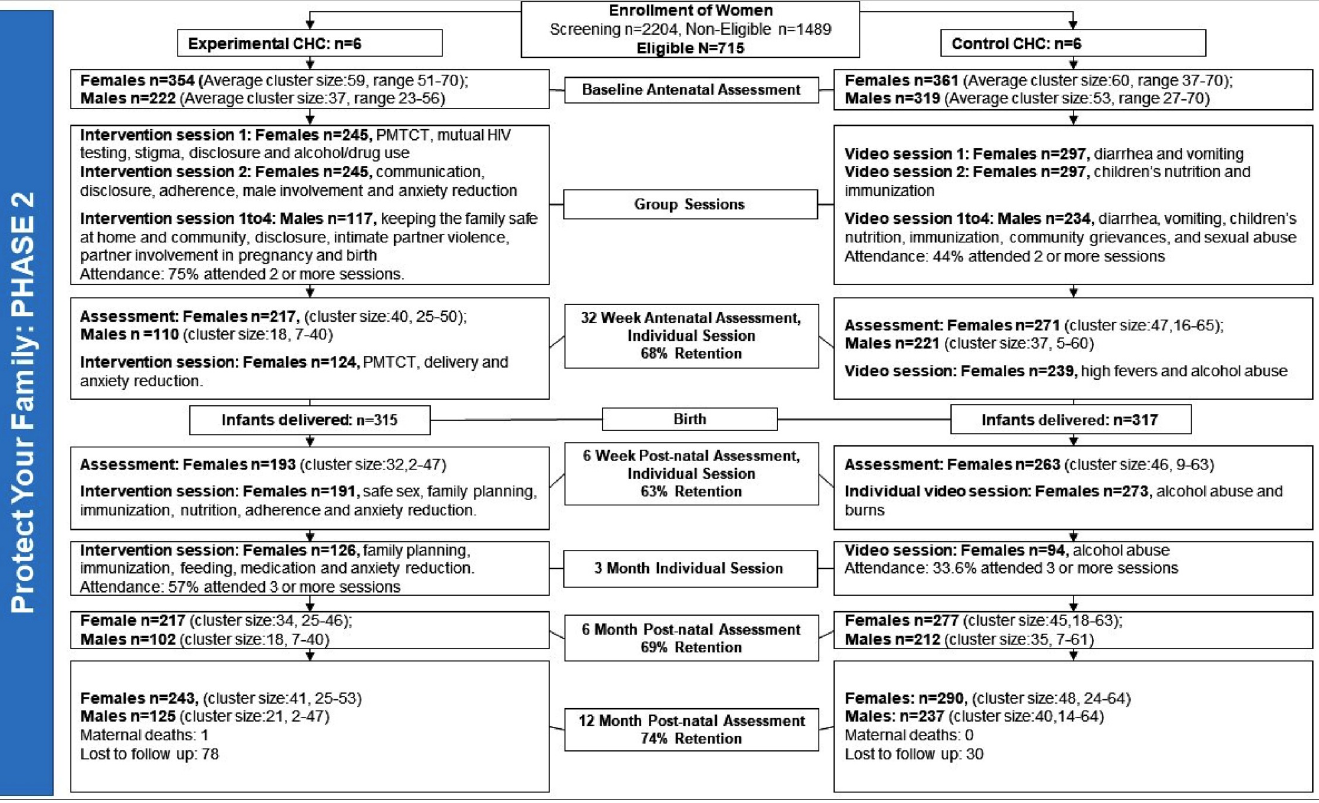
Fig 2. CONSORT diagram outlining enrolment procedures for Phase